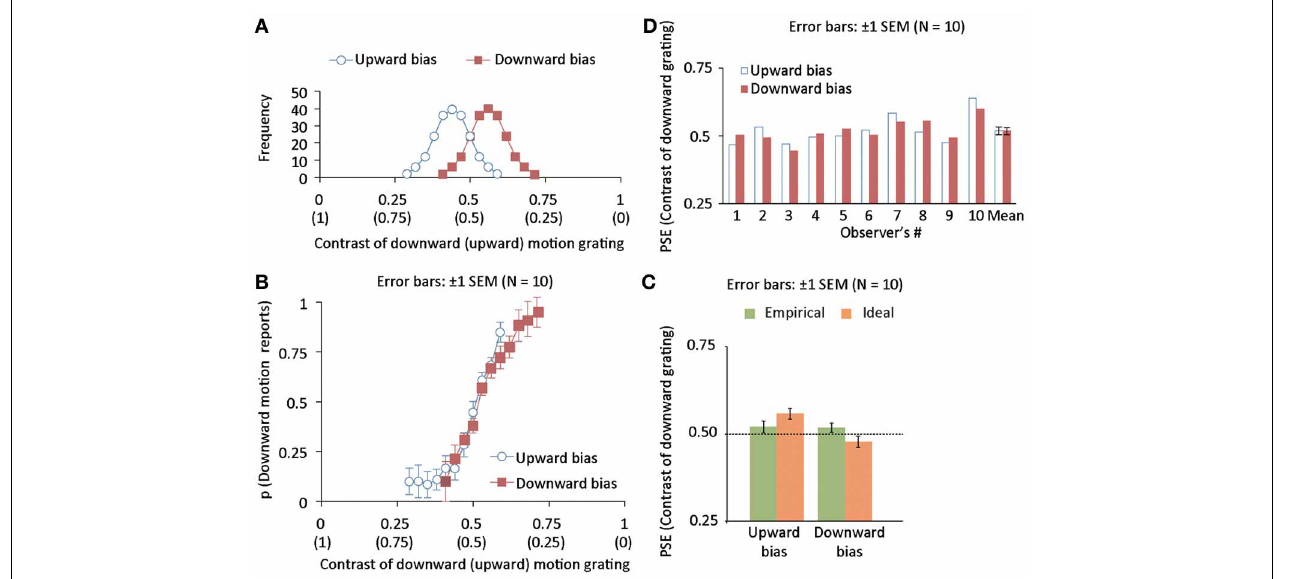
FIGURE 4 | (A) Distributions of luminance contrast for downward (and upward) drifting gratings in upward (blue, open disk maskers) and downward (red, open square markers) bias conditions. The mean of the distribution is deviated from 0.5 by 0.06 negatively and positively for upward- and downward-bias conditions. The standard deviation of the